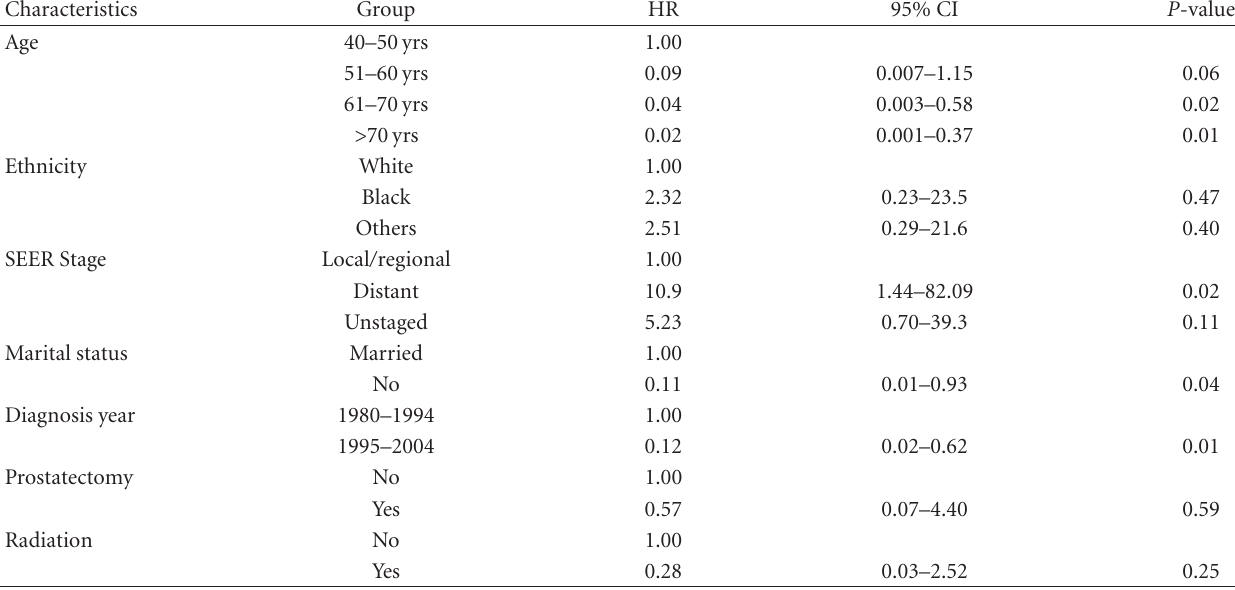
Table 6: Multivariate Analyses of Factors Associated with Cancer-Specific Mortality in Patients with Signet Ring Prostate